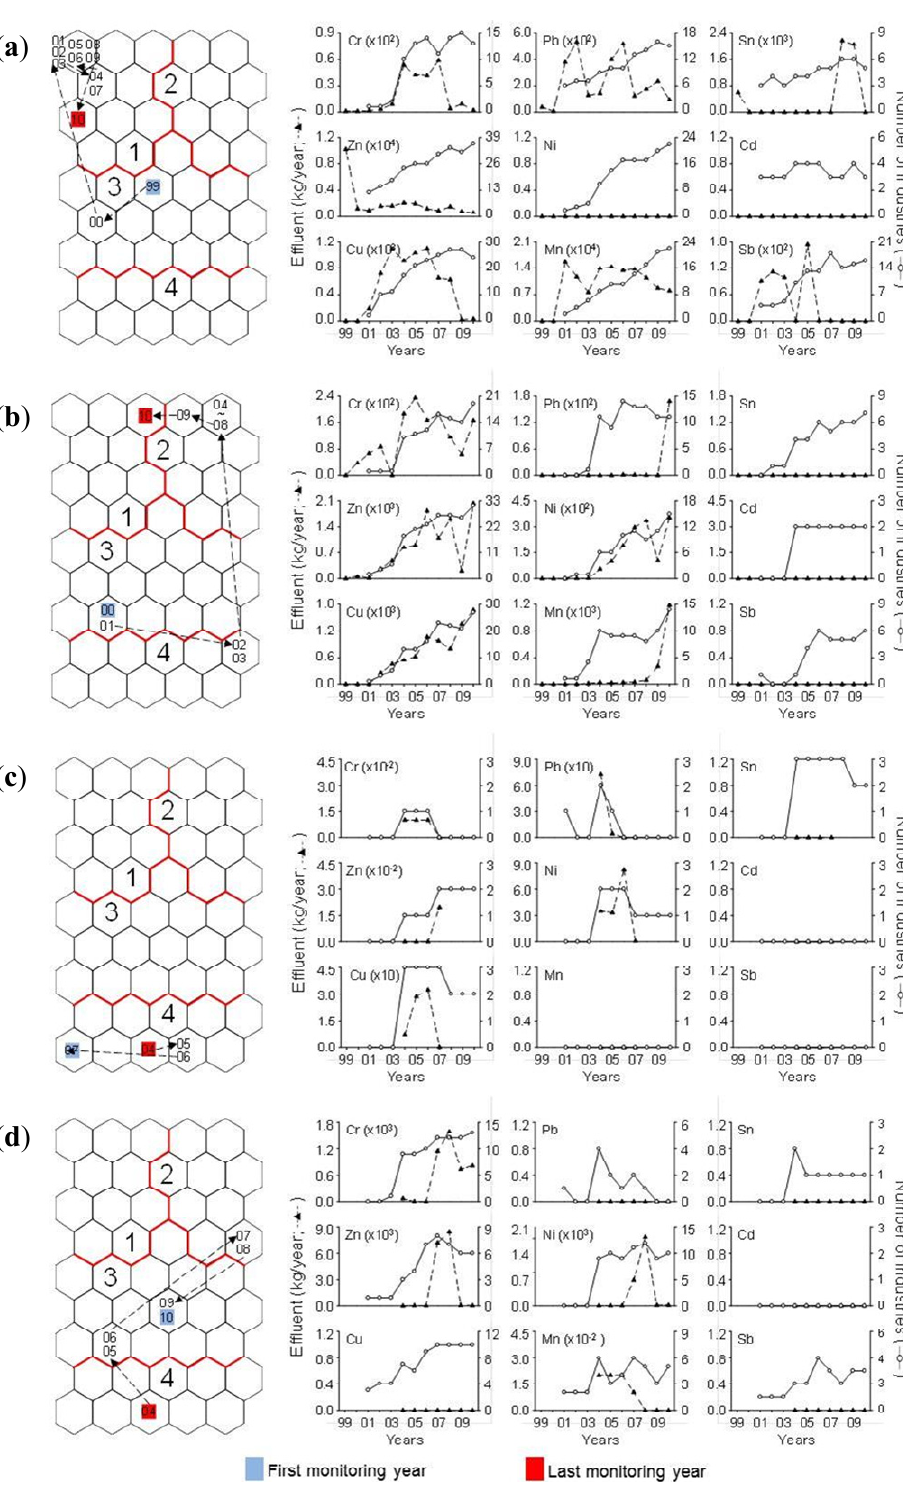
Figure 8. Examples of temporal changes in the effluent patterns of heavy metals in the SOM map and annual changes in the effluents of nine heavy metals at ( a ) Ulsan, ( b ) Chungnam, ( c ) Seoul, and ( d ) Daegu. Two digit numbers in the SOM maps indicate years (for example, 99: 1999, 01: 2001, etc.